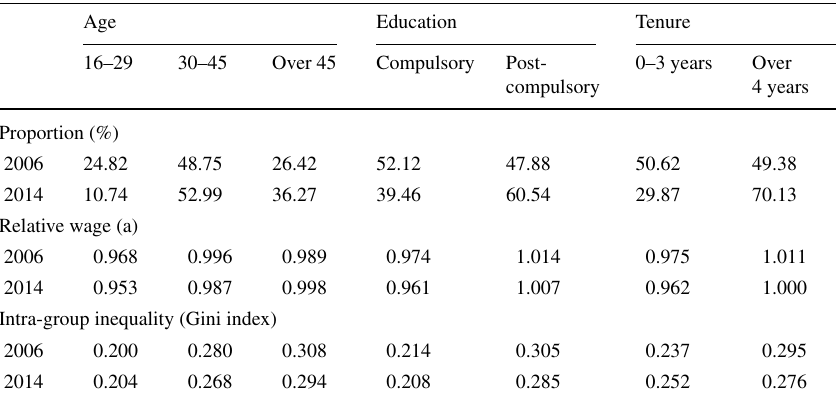
Table 6 Changes in the characteristics of employees 2006–2014. Source : National Statistics Institute (EES) Age Education